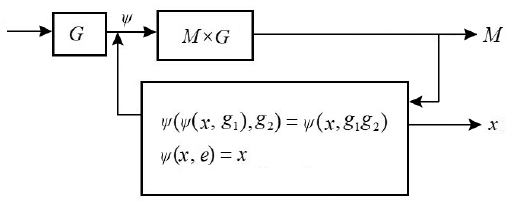
Fig. 3 Right effect model of Lie group machine